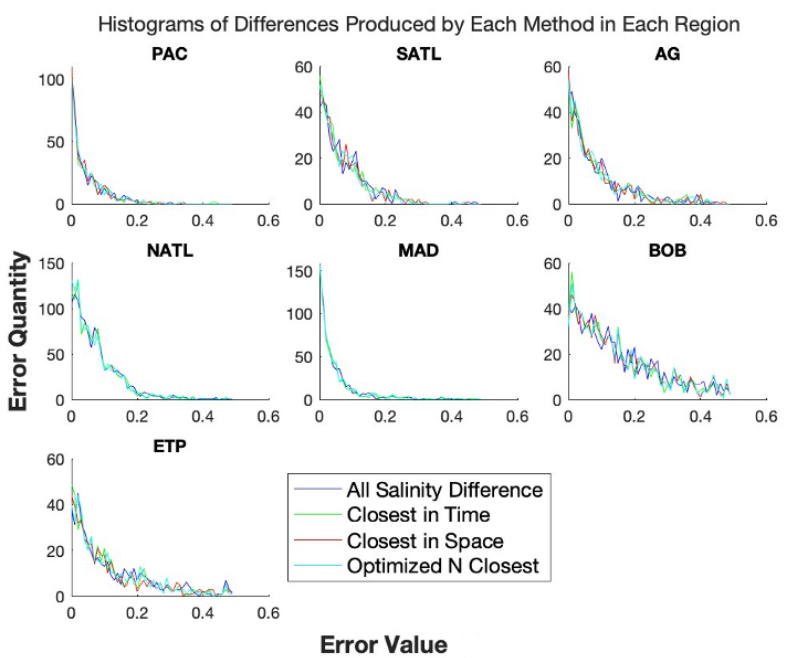
Figure 7. Histograms of the differences produced using each of the four matchup methods on the simulated Aquarius satellite data. In the NATL and MAD regions, the errors produced for the SSDS and NCLO methods are the same because the optimum space_weight in these regions is high (between 0.9 and 1) and the optimum N value is 1. This is an example of a single salinity difference method being optimum for the